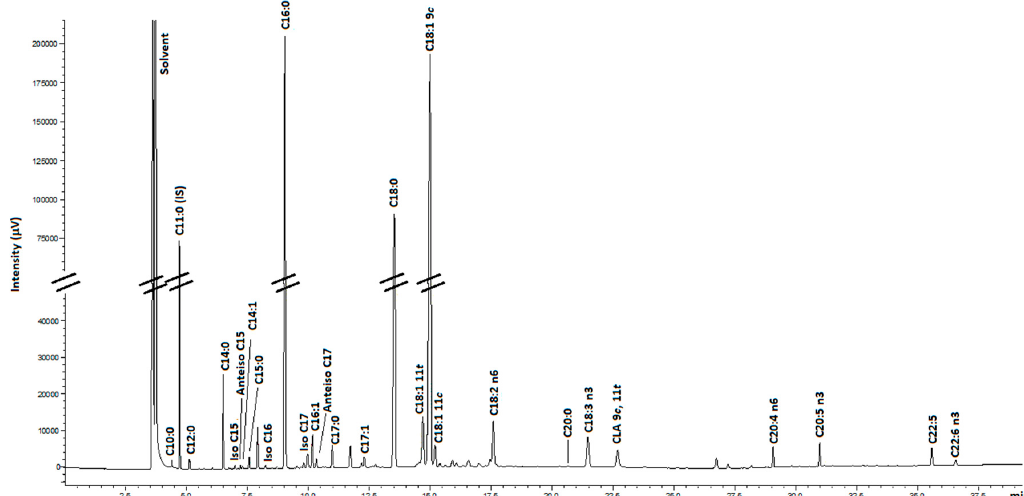
Figure 1. GC chromatogram representative meat FAMEs (fatty acids methyl esters). Legend. Methyl esters of: capric acid (C10:0), undecanoic acid (C11:0)—internal standard, lauric acid (12:0), myristic